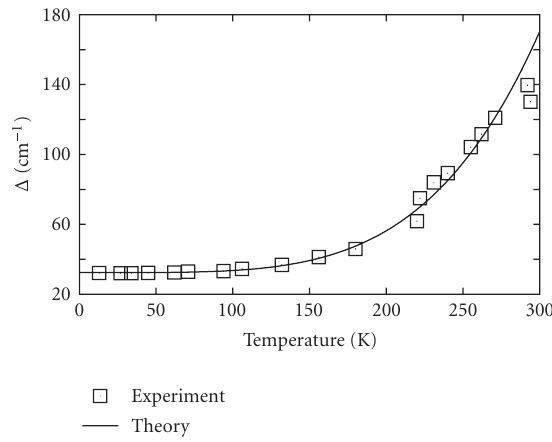
Figure 4: Simulated (solid line) and measured (squares) full width at half maximum of the J-band of PIC-Cl aggregates as a function of temperature. Simulation parameters were σ = 0 . 13 J and W 0 = 16 . 0 J with J = 600 cm − 1